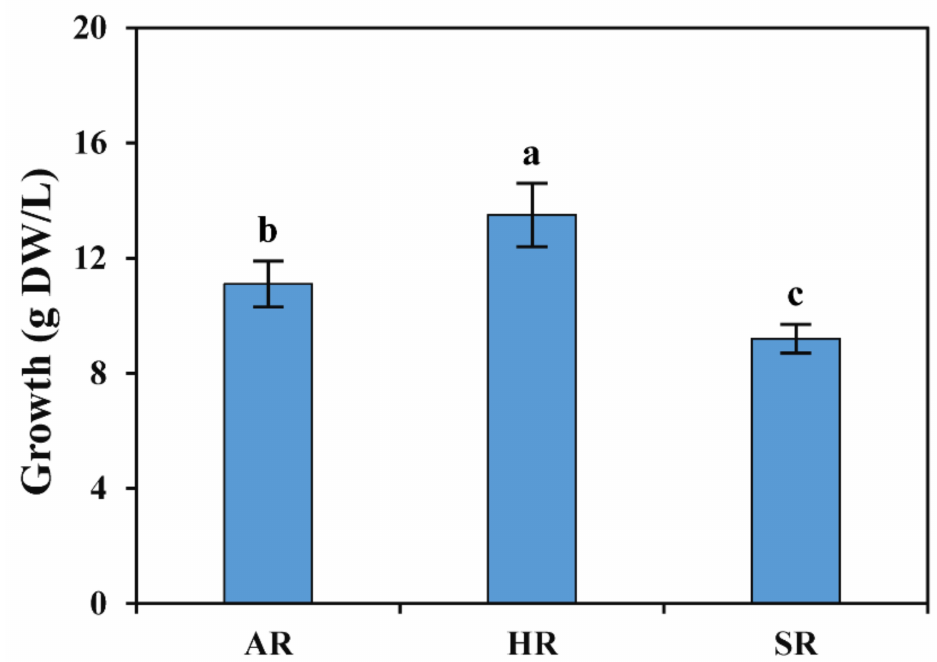
Figure 2. Growth of different types of root cultures of F. tataricum in a flask. Values followed by different letters within a column indicate a significant difference ( p < 0.05) between areas for that parameter using DMRT ( n ≥ 5, mean ±